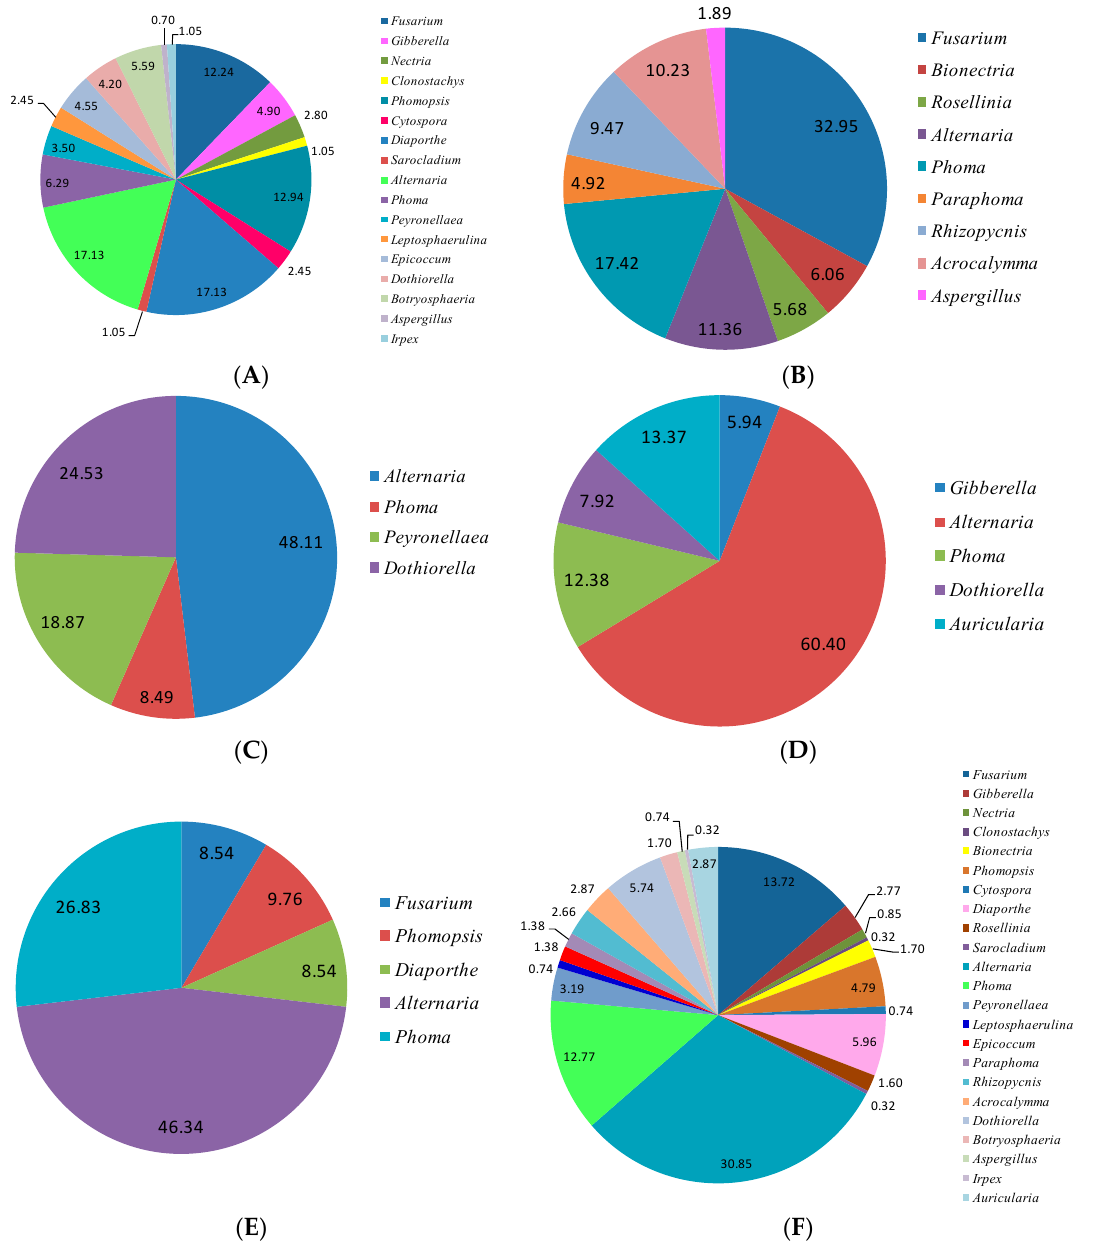
Figure 3. Relative abundance (RA, %) of endophytic fungal at the level of genera in stem ( A ); root ( B ); fruit ( C ); leaf ( D ); thorn ( E ); and total plant ( F ) of Z. bungeanum .